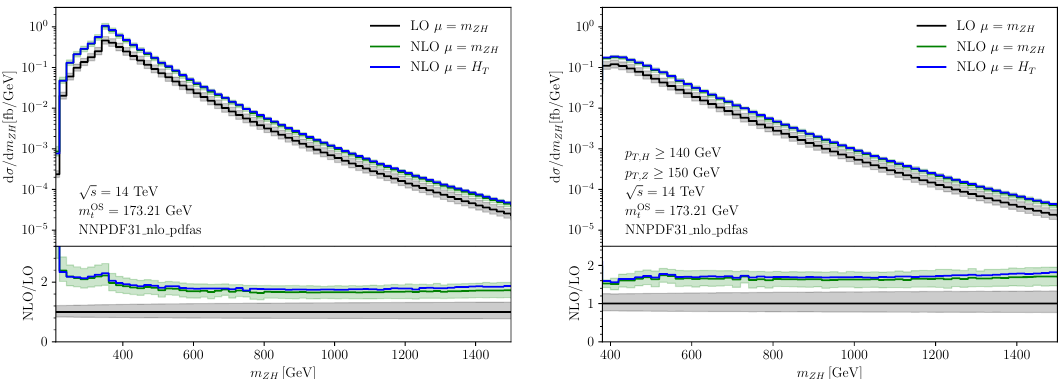
Figure 5. Invariant mass distribution at LO and NLO, including scale uncertainties resulting from a 7-point scale variation around the central scale µ = µ NLO predictions for µ = H p T,Z ≥ 150